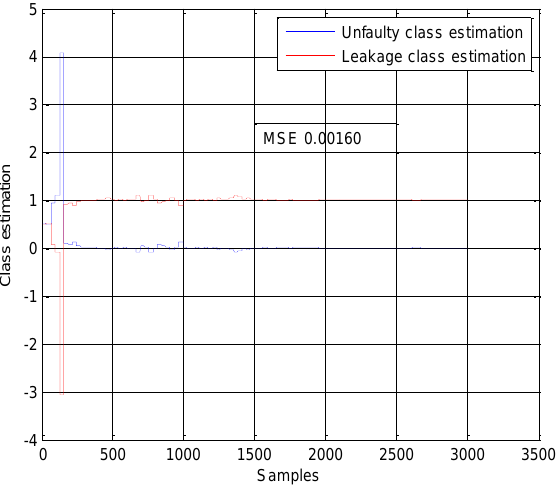
Figure 9. Engine_speed = 1000 rpm and torque = 130 Nm.